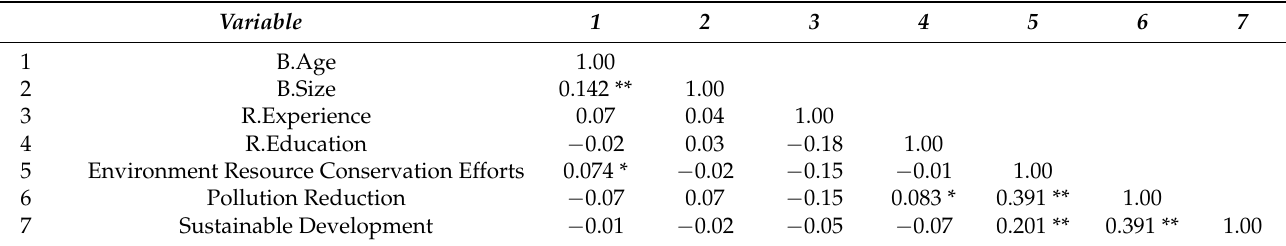
Table 3. Correlation results.